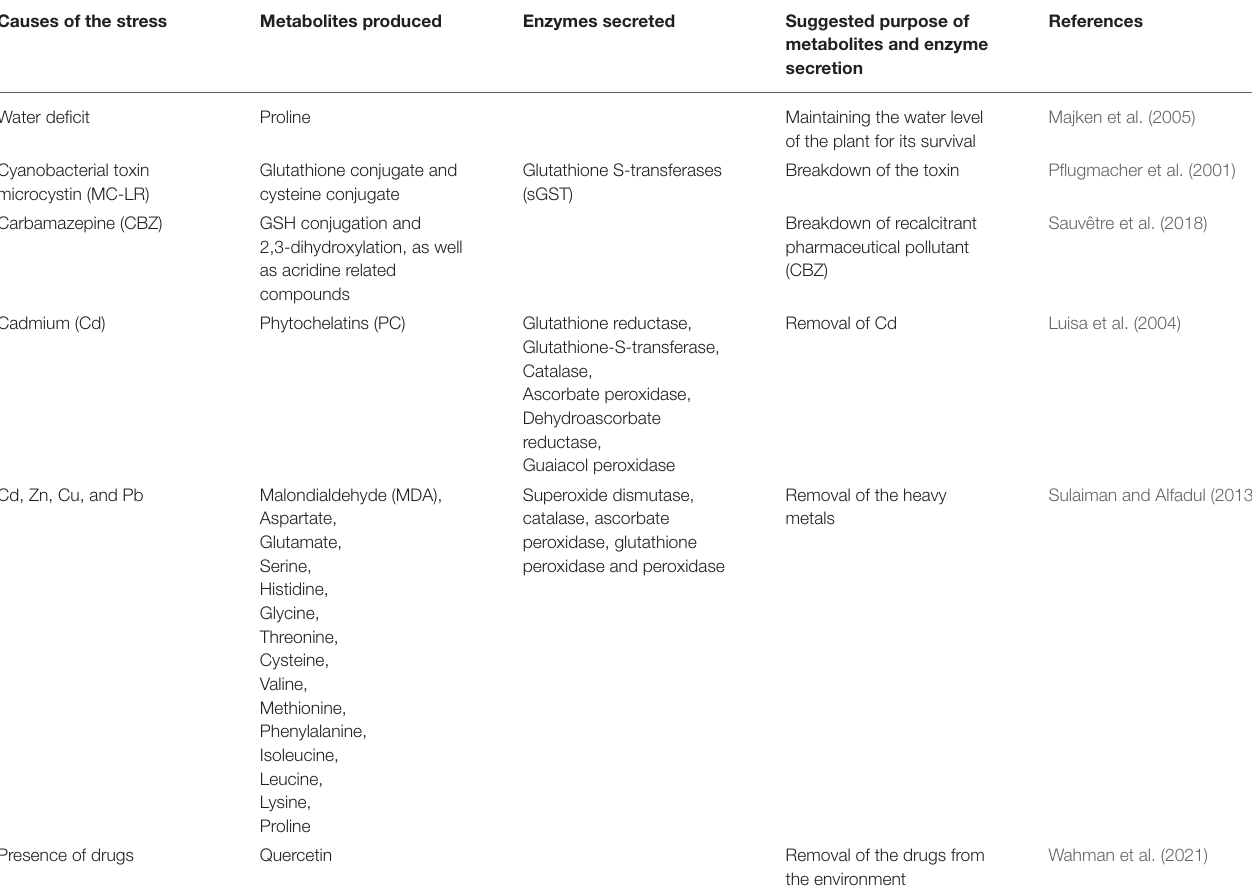
TABLE 2 | Summary of the metabolites produced, and enzymes synthesized by P. australis in response to